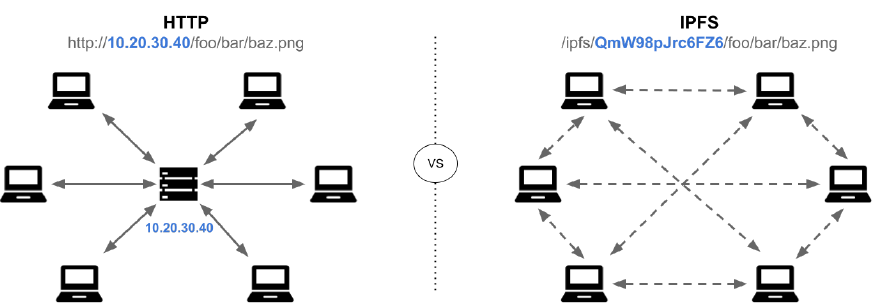
Figure 3. A brief IPFS overview: the classical HTTP protocol used in the web uses location addresses, relying on a centralized architecture in which users connect to the central server (location) which provides the file. Instead, IPFS uses content addresses, where users can retrieve files that are uniquely identified from any node in a distributed network that stores that